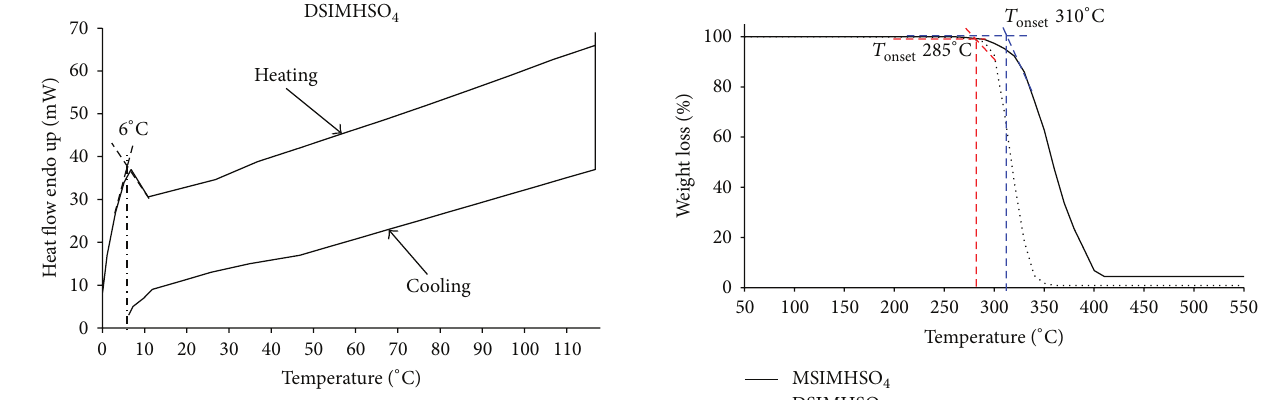
Figure 3: DSC curve for melting point determination of DSIMHSO 4 .